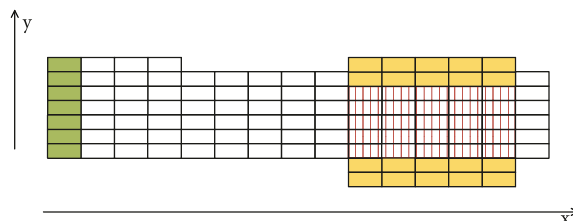
Figure 5: Illustration of modeling scenefor harbor-shapedbus stop.